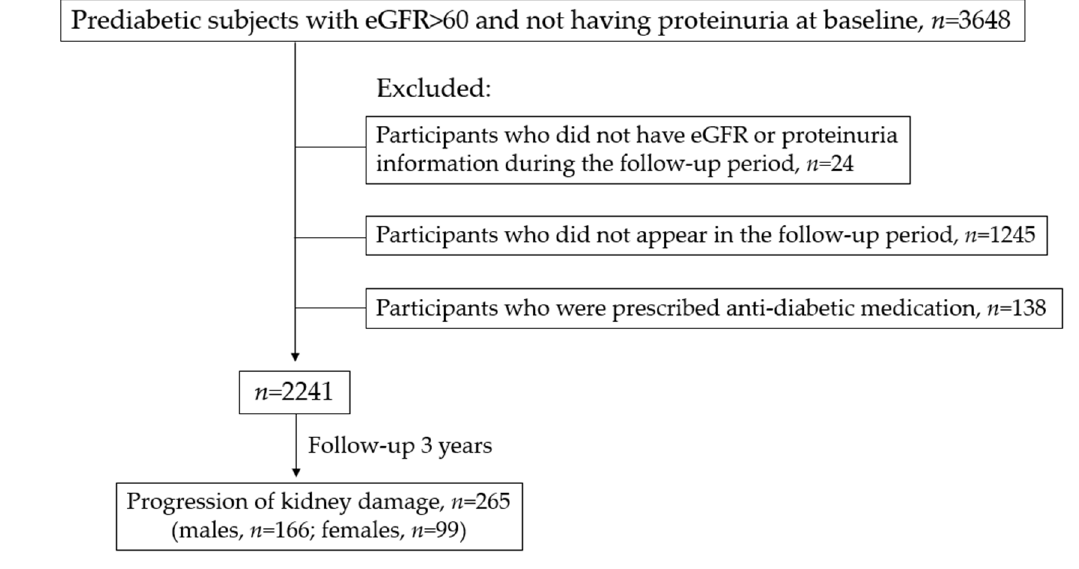
Figure 1. Study flow chart. Figure 1. Study fl ow chart. Table 1. Baseline characteristics of the study subjects. Table 1. Baseline characteristics of the study